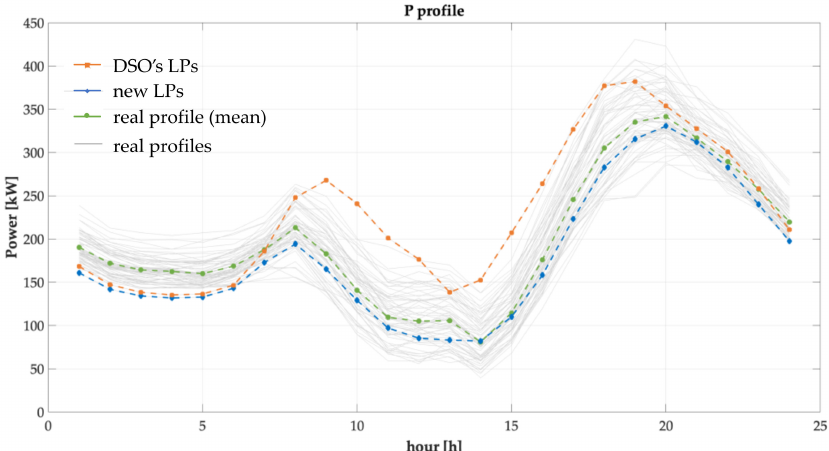
Figure 18. Power profile at the medium voltage (MV)/low voltage (LV) transformer (winter working